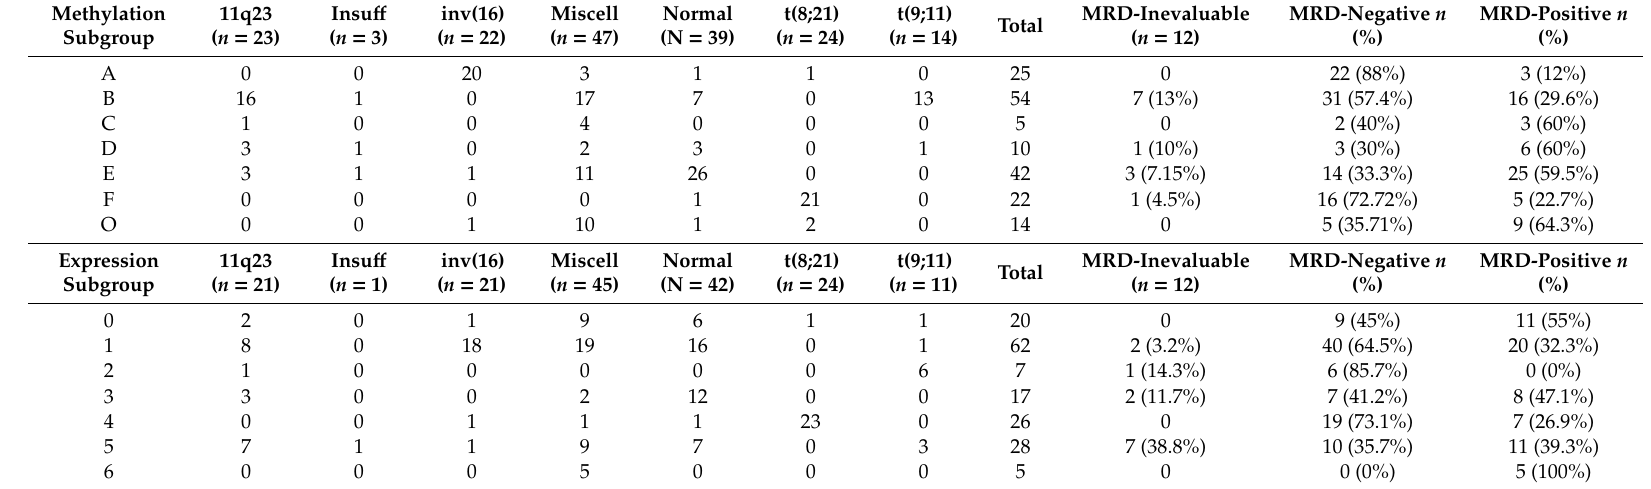
Table 1. Summary of methylation and Gene expression clusters identified by unsupervised analysis.